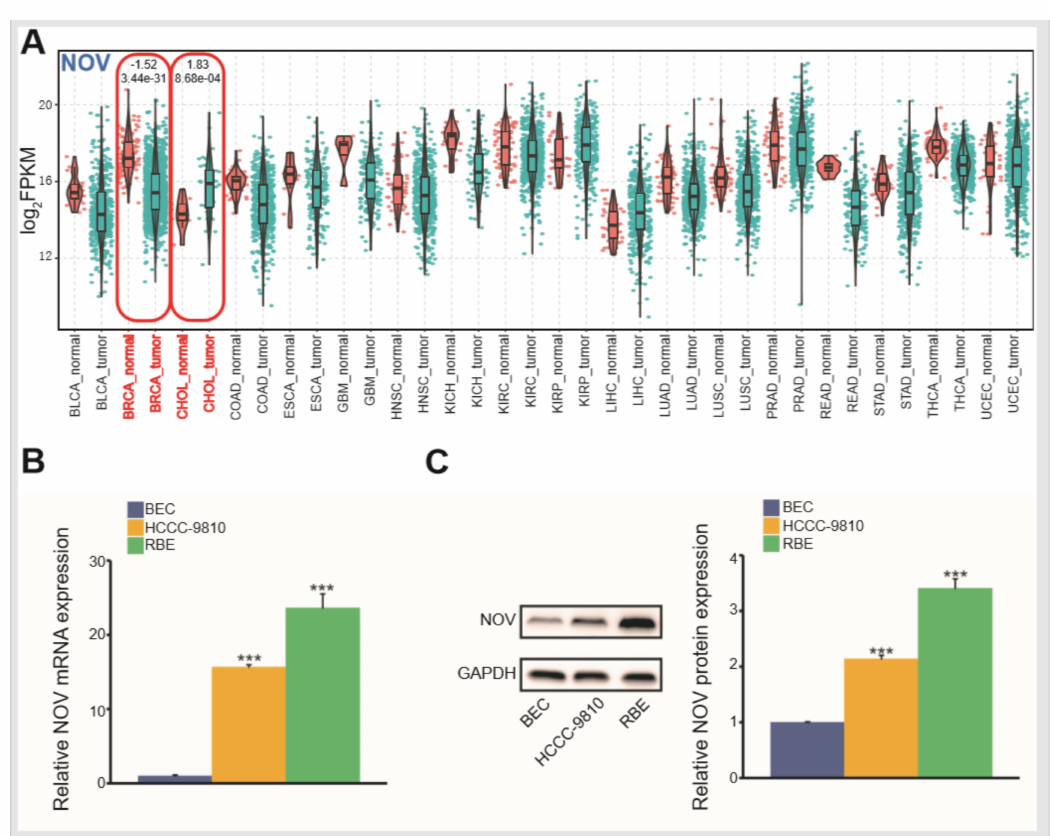
Figure 2. Expression analysis and experimental validation. ( A ) Pan-cancer analysis of screened NOV across cancer types based on tumor and normal samples. The red circled part means that there are significant difference on the expression of NOV in BRCA and CHOL (Tumor vs. Normal) ( B ) NOV mRNA expression based on the q-PCR method. *** indicates p < 0.001. ( C ) NOV protein expression based on Western blot. *** indicates p <